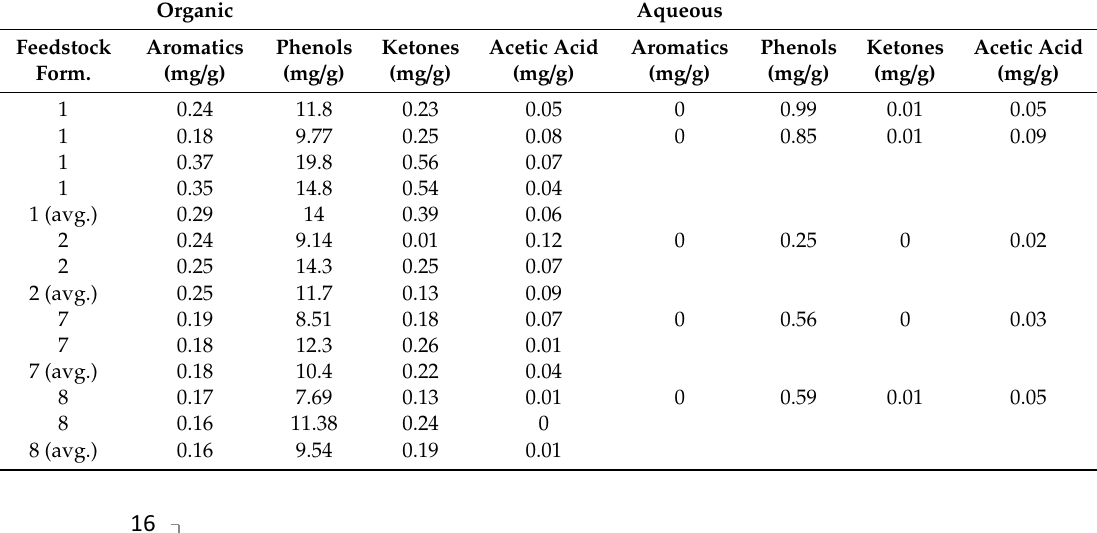
Table 5. GC-MS analysis of organic and aqueous phases of liquid product.